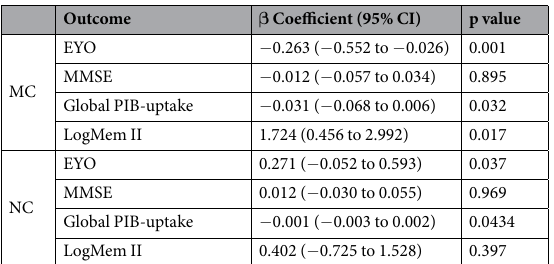
Table 3. Association between body mass index (BMI) and cognition, and imaging parameters in preclinical (CDR = 0) mutation carriers (MCs) and non-mutation carriers (NCs). Note: Results are for linear regression. BMI was the predictor, adjusted for participant age, education and gender. Log Mem II = Logical Memory test, delayed recall; Global PIB-uptake = global cerebral A β burden as measured by 11 C-Pittsburgh Compound-B